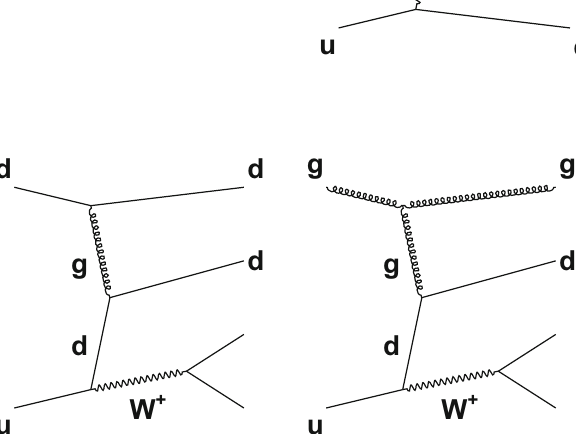
Fig. 1 Representative Feynman diagrams for lepton–neutrino production in association with two jets from purely electroweak amplitudes: vector boson fusion (left), bremsstrahlung-like (center), and multiperipheral (right) production